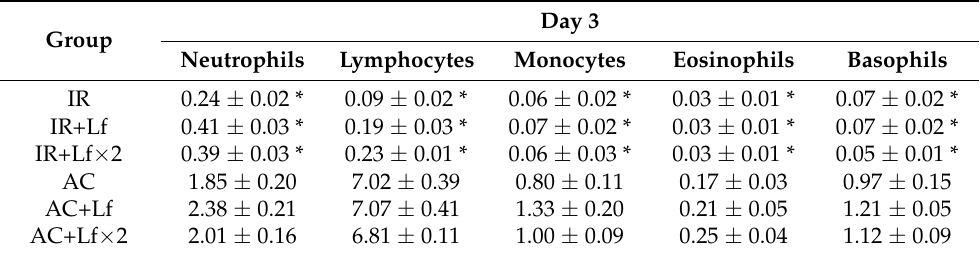
Table 1. Absolute number of leukocytes of different types in the blood of mice on day 3 after 7.5 Gy gamma irradiation ( × 10 6 /mL), Mean ± SEM. Group